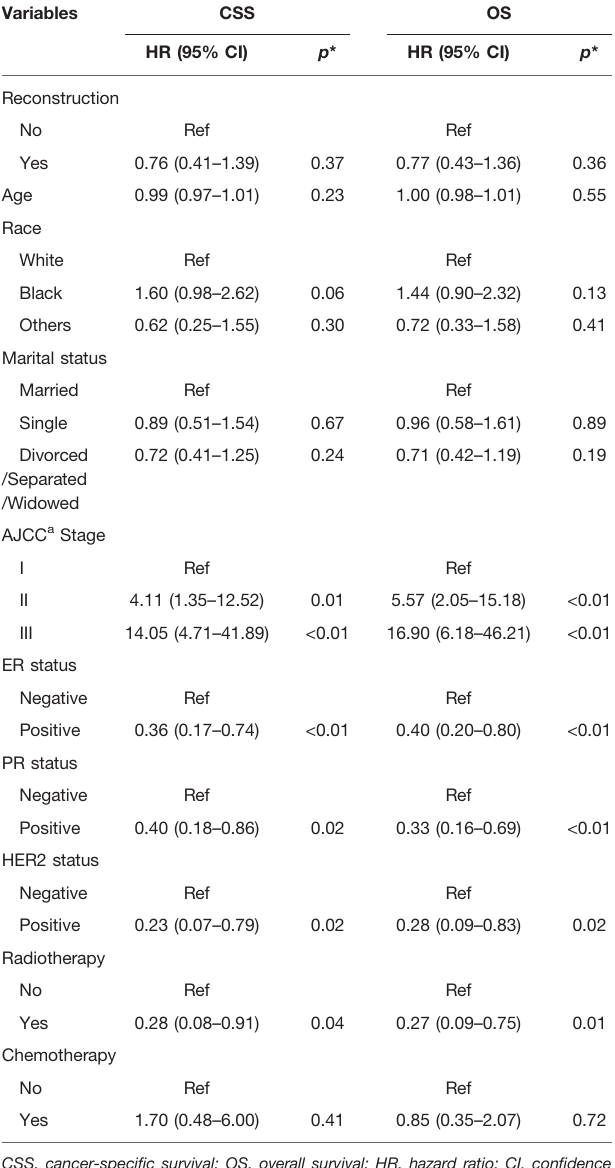
TABLE 3 | Multivariable Cox proportional hazard regression model of cancer- speci fi c survival and overall survival.